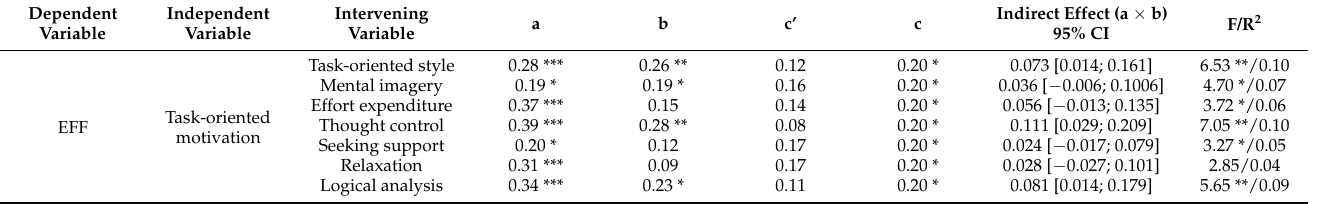
Table 2. Mediational analysis for the relationship between task orientation, strategies of coping with stress, and effectiveness of performance.